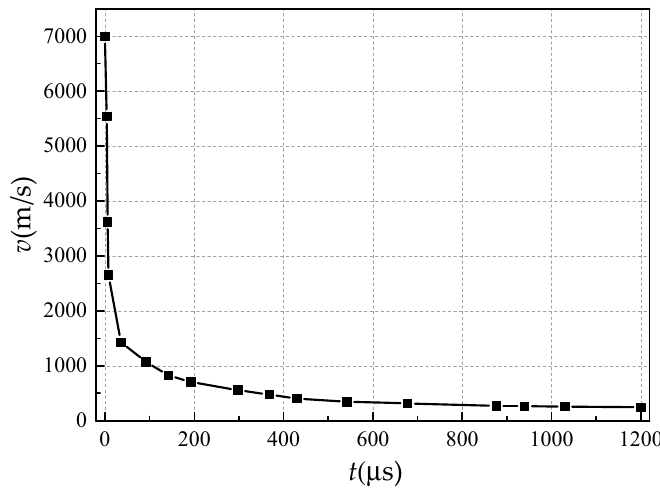
Figure 5. The velocities of debris at different times obtained by the simulation results.